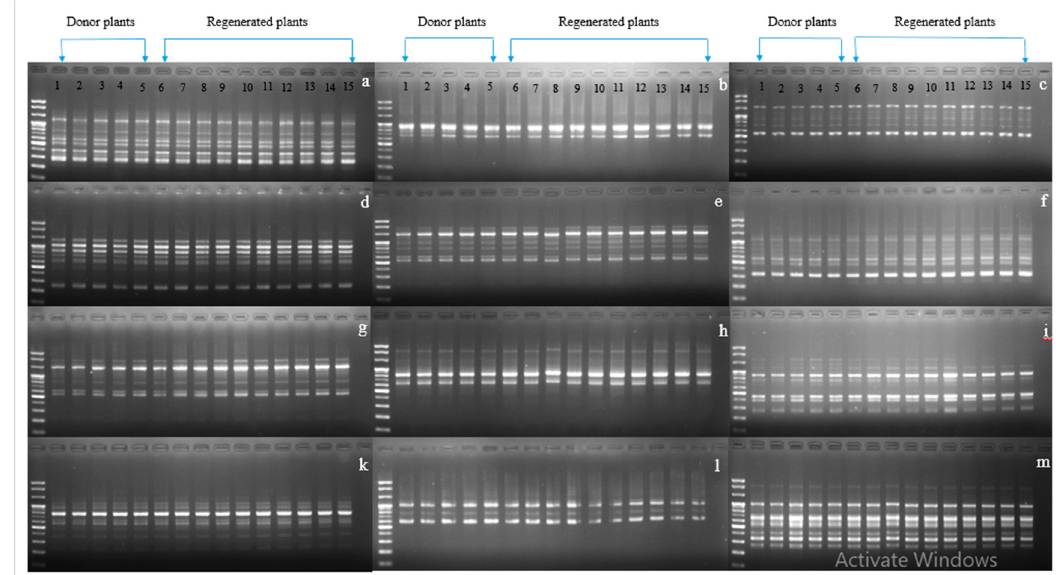
Figure 7. Showing genetic stability between vitrified-derived plants and donor plants using RAPD markers in cultivar Denev (DNV). ( a ) OPA 03, ( b ) OPA 07, ( c ) OPA 10, ( d ) OPA 18, ( e ) OPA 19, ( f ) OPA 20, ( g ) OPB 12, ( h ) OPB 17, ( i ) OPB 18, (j) OPA 09, ( k ) OPB 07, ( l ) OPB 10.